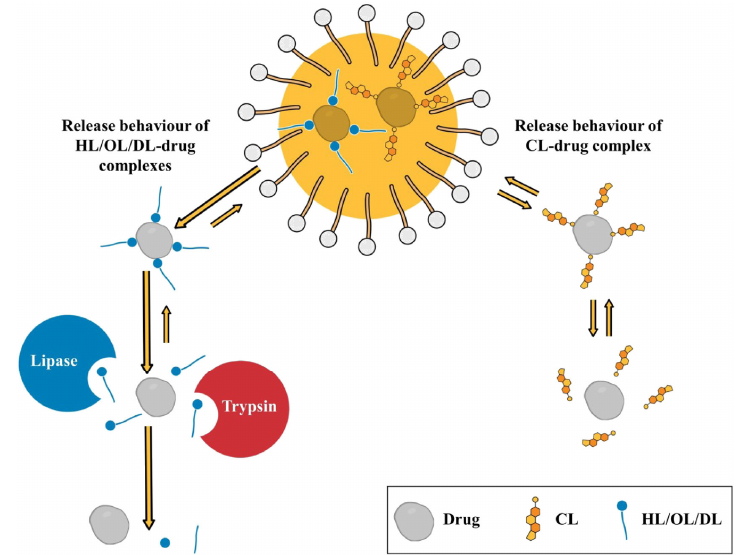
Figure 4. Anticipated release behavior of hexadecyl lysinate (HL), oleyl lysinate (OL) and decyl lysinate (DL)-drug complexes in comparison to the release of cholesteryl lysinate (CL) complexes out of lipid-based nanocarrier systems